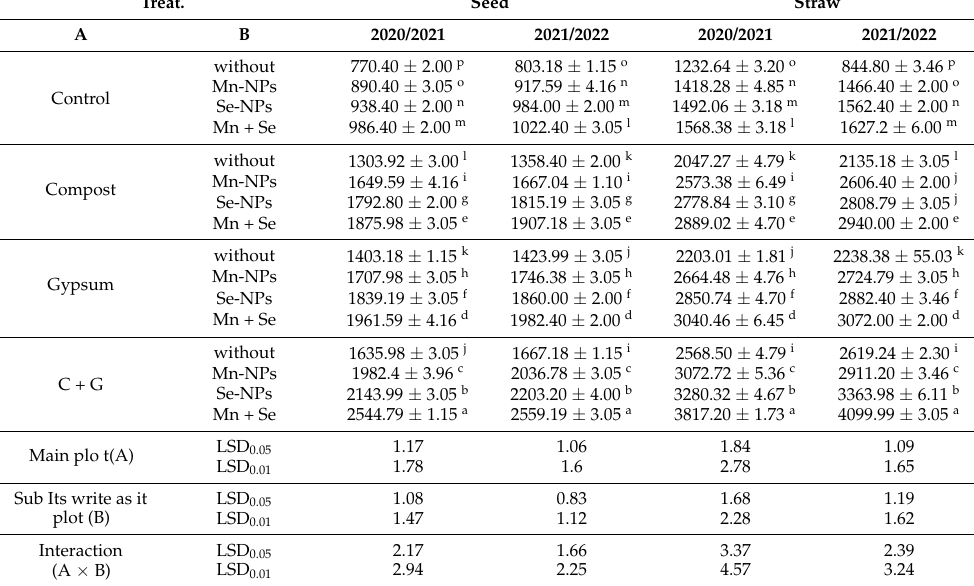
Table 6. Effect of the application of selected soil amendments and nanoparticles on seed and straw yields of faba beans (kg ha − 1 ) during the 2010/2021 and 2021/2022growing seasons. Treat. Seed